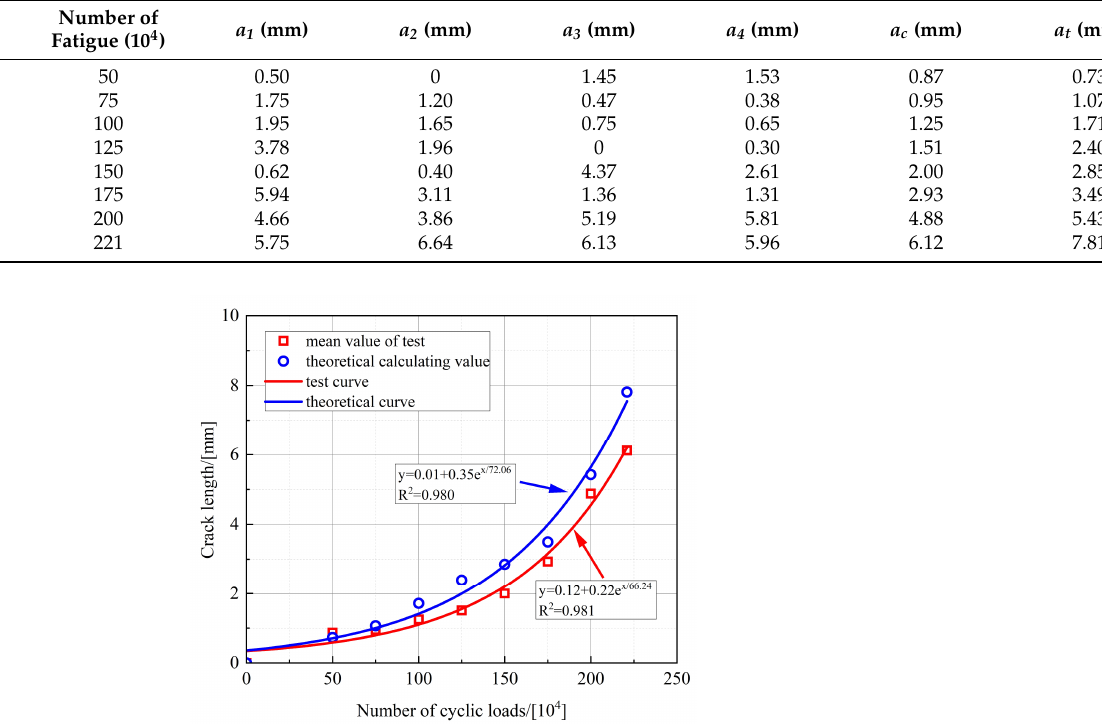
Figure 11. Variation in the crack depth with the number of fatigue loading cycles.